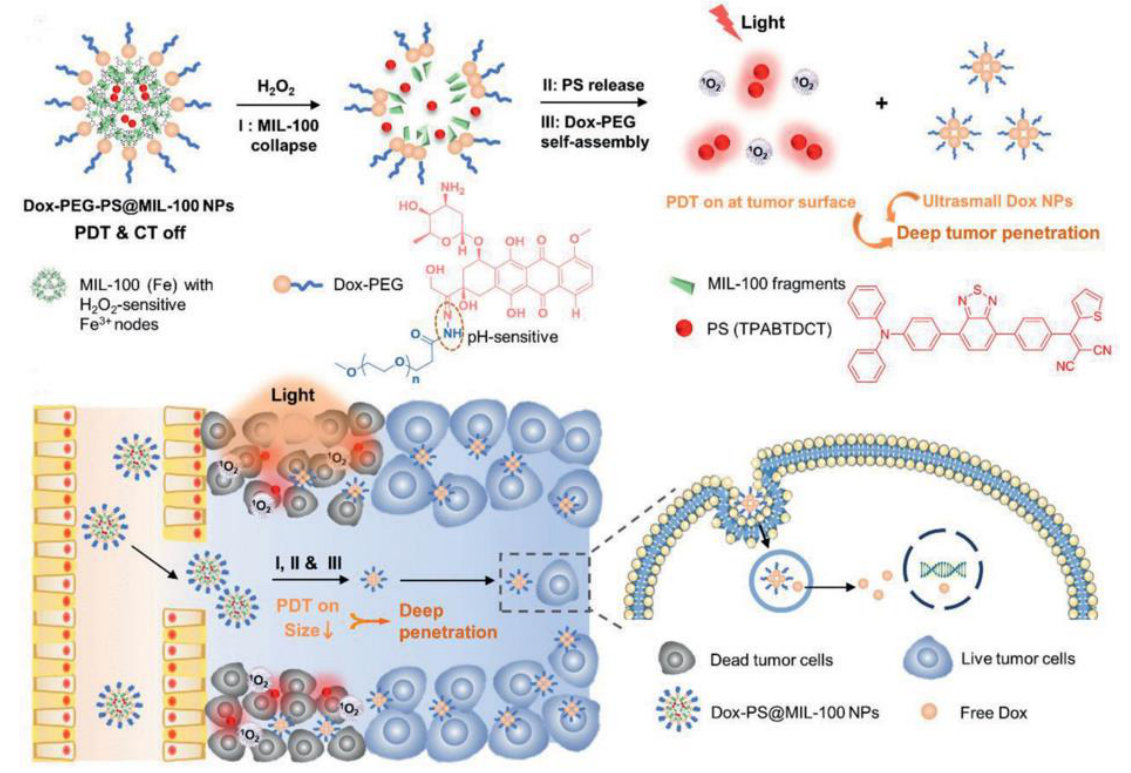
Figure 25. Schematic illustration of Dox-PEG-PS@MIL-100 NPs for advanced photodynamic– chemotherapy combination therapy. Reprinted with permission from Ref. [160]. Copyright 2021 WILEY- VCH.